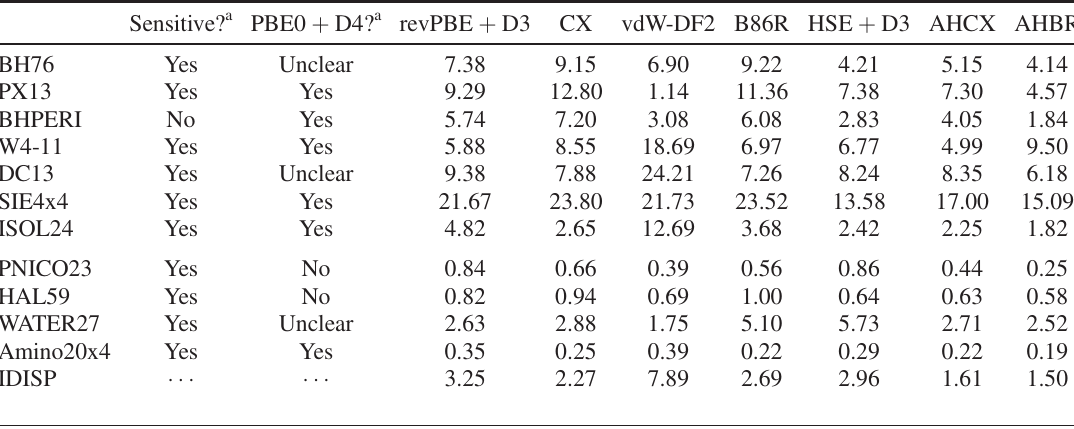
TABLE IV. Comparison of revPBE þ D 3 , CX, vdW-DF2, HSE þ D 3 , AHCX, and AHBR performance on benchmark sets that are density sensitive, here as asserted from comparing self-consistent PBE þ D 4 and HF- PBE þ D 4 performance measures. For key benchmark examples, the second column asks, “ Is the MAD value for HF-PBE þ D 4 [namely, the key element of DC(HF)-PBE þ D 4 ] better than it is for regular (self-consistent) PBE þ D 4 ? ” using a GMTKN55 survey of density-corrected PBE [197]. The answers are practical identifications of sensitivity. The third column uses those data [197] to answer the question, “ Does PBE 0 þ D 4 outperform HF- PBE þ D 4 for this benchmark set? ” I.e., it assesses if an unscreened hybrid can itself be expected to correct for the density sensitivity. The first and bottom sections of the table contrast benchmark performances (listed as MAD values in kcal/mol) for GMTKN55 groups 1 – 3 and in the inter- and intramolecular NOC-interaction groups 4 and 5,